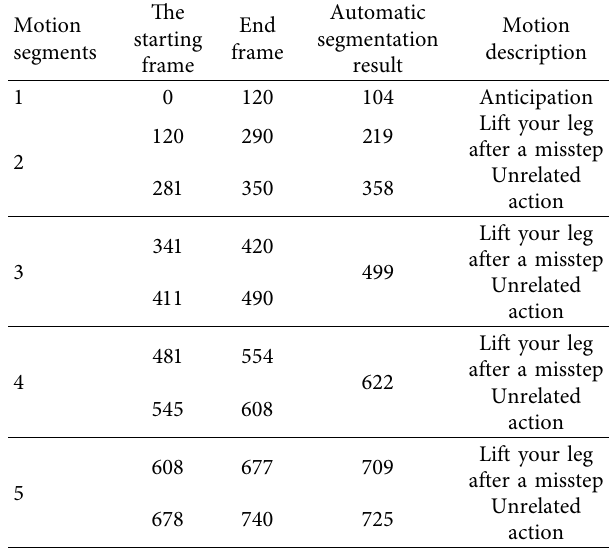
Table 3: Comparison between manual segmentation and auto- matic segmentation.